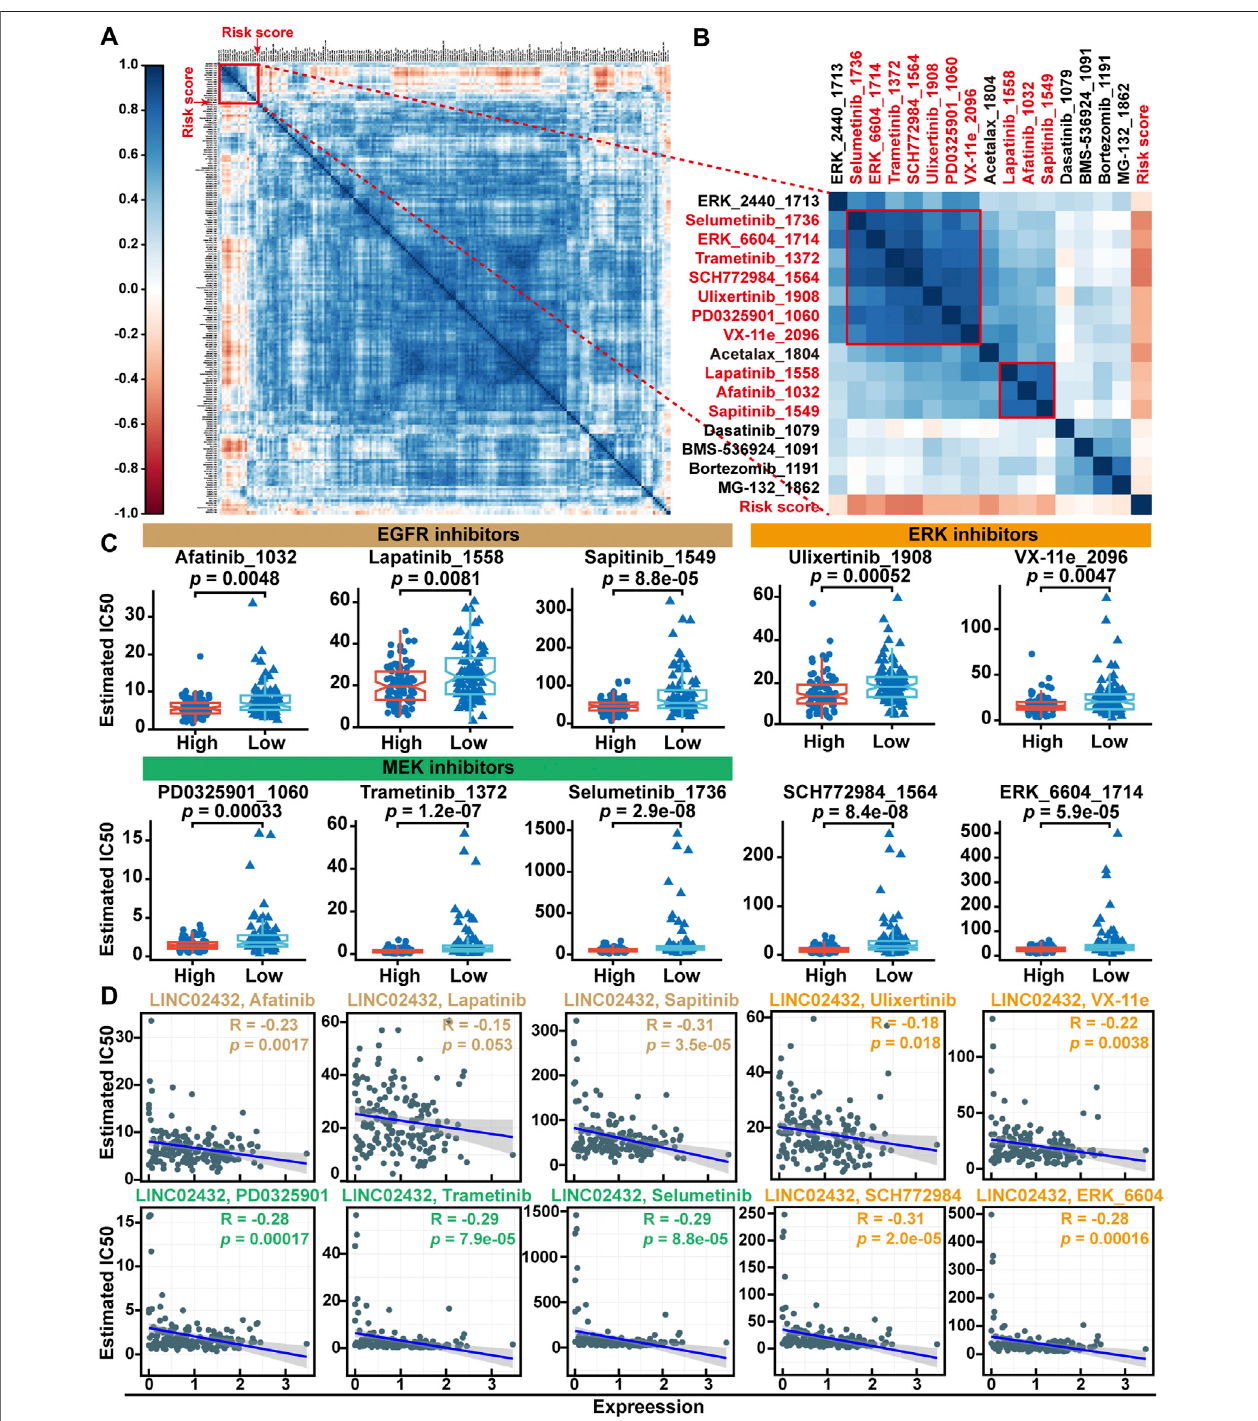
FIGURE 9 | Drug sensitivity analysis of the risk score. (A) The correlation heatmap between the IC50 values of anti-tumor drugs and risk score. (B) Correlation heatmapshowingtheassociationoftwoclustersdrugs(containing10compounds) withriskscores. (C) DifferentialanalysisofdrugIC50valuesbetweenhighriskscore and low risk score groups. (D) Scatter plots showed correlation between IC50 values of 10 compounds and lINC02432 expression.